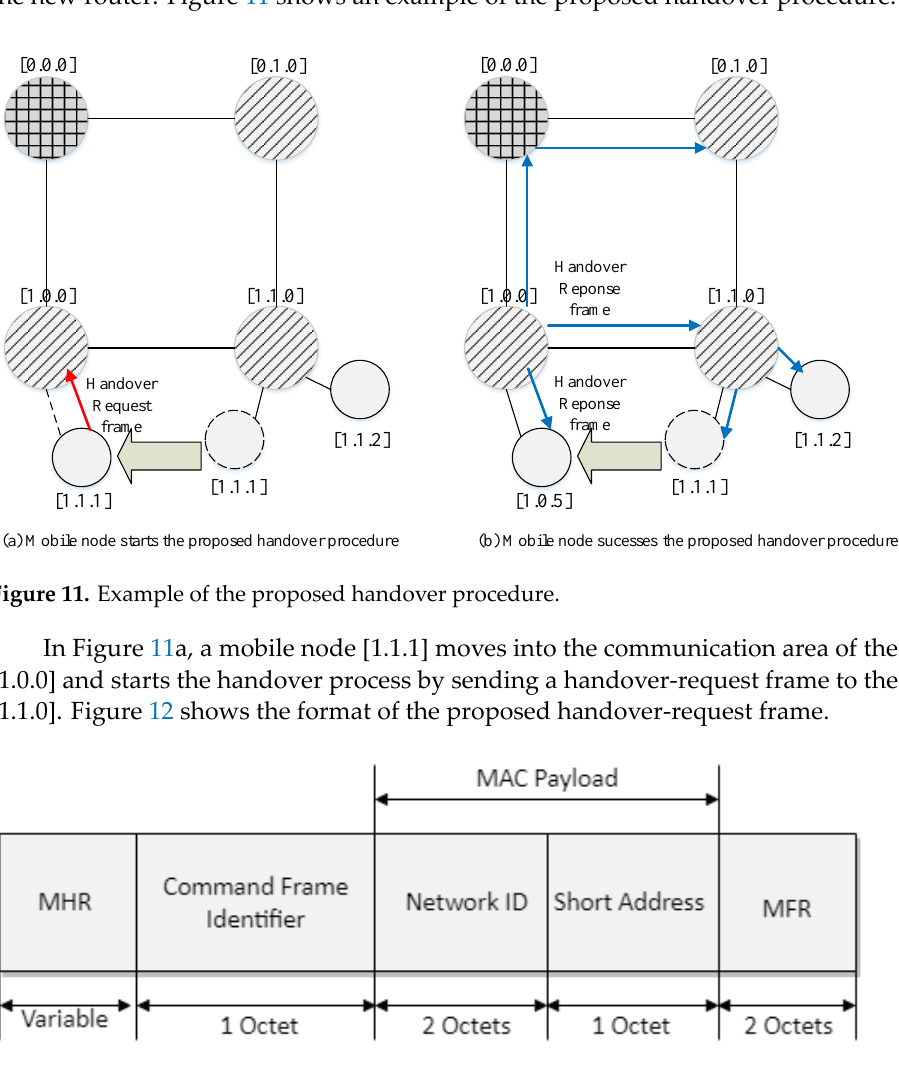
Figure 13. The proposed handover-response frame structure.